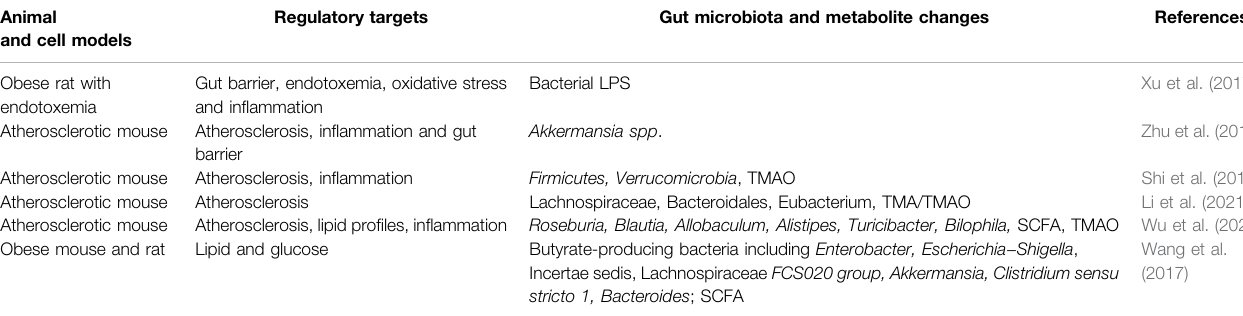
TABLE 2 | Berberine ameliorates dysmetabolism and atherosclerosis via interacting with gut